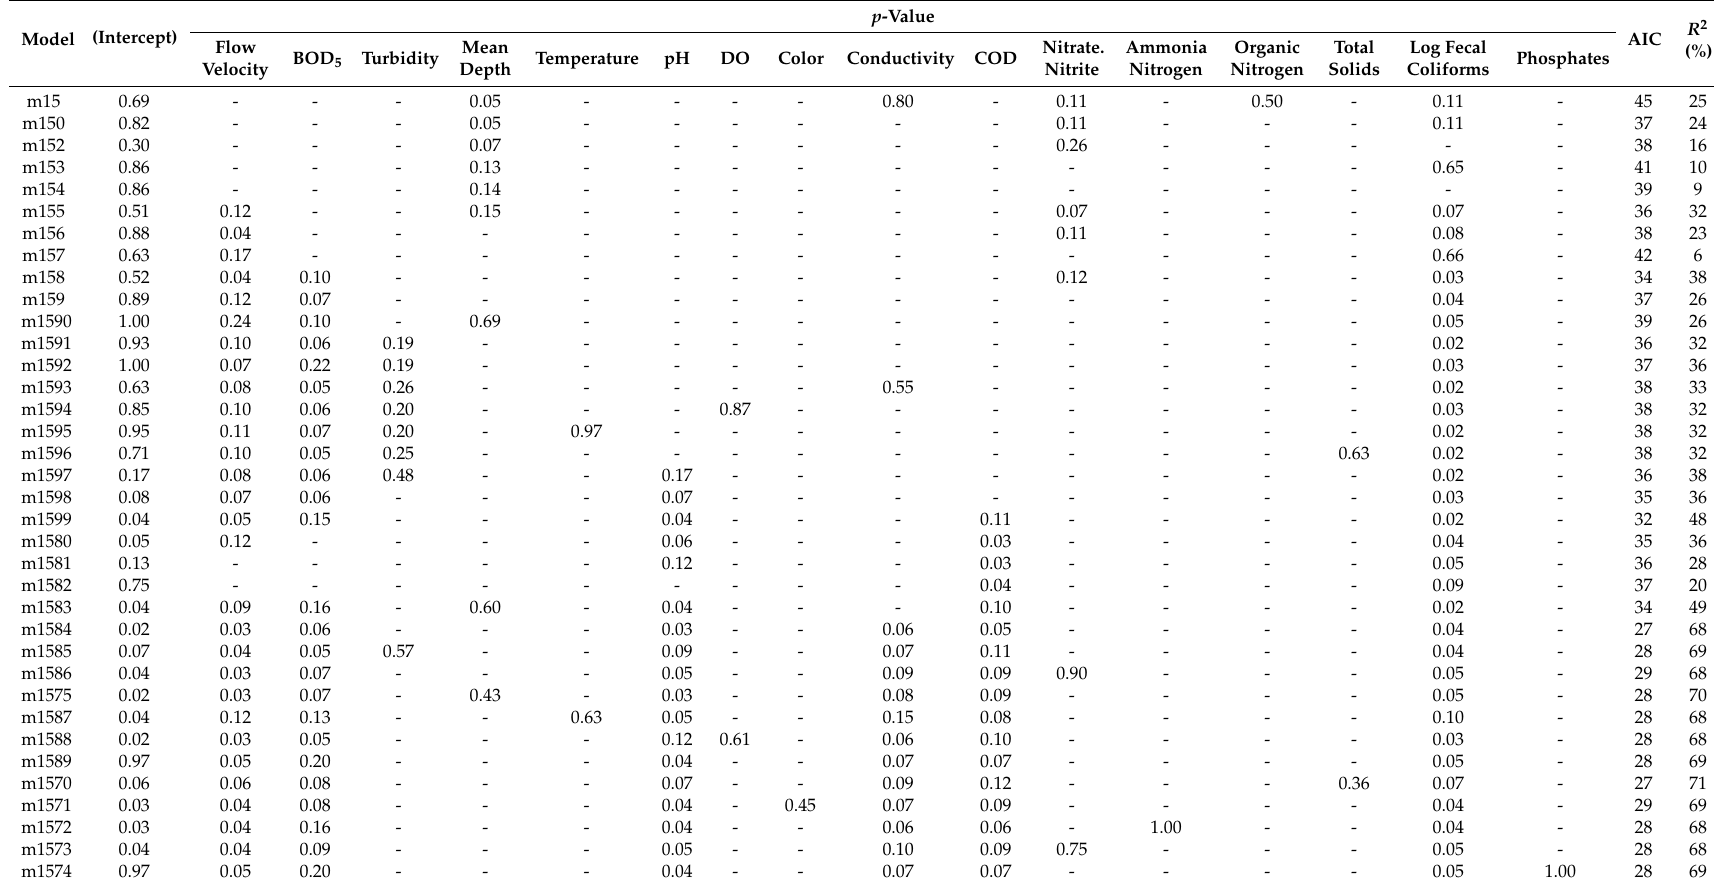
Table A4. Process of model development for Leptoceridae : p -values, AIC and adjusted R 2